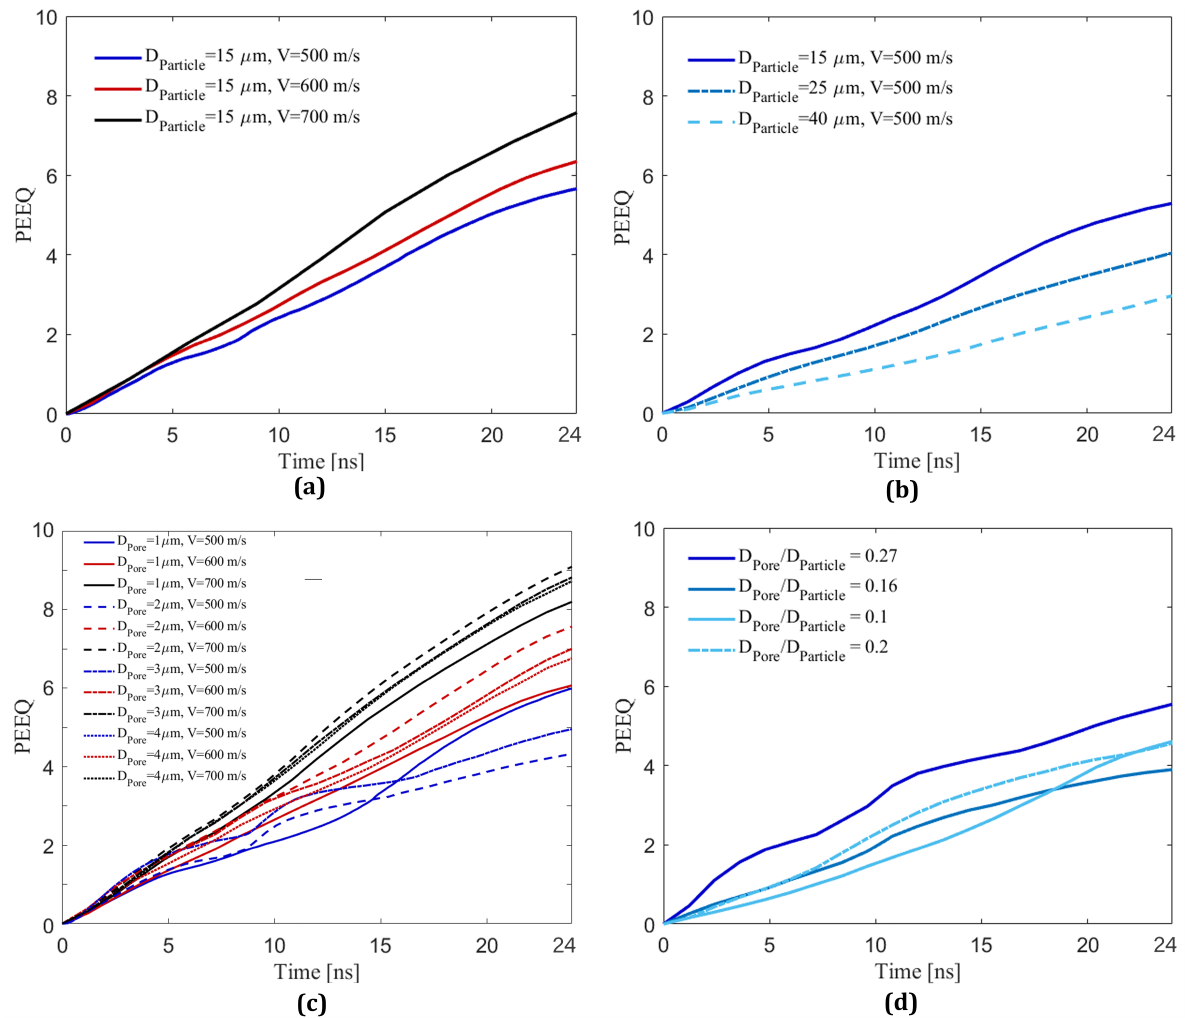
Figure 8. Time-evolved equivalent plastic strain (PEEQ) over the contact-surface between the Al substrate and the B 4 C particle in the Al substrate. ( a ) Particles with D Particle = 15 µ m and V Impact = 500, 600, and 700 m/s. ( b ) Particles with D Particle = 15, 25, 40 µ m and the V Impact = 500 m/s. ( c ) D Particle = 15 µ m and V Impact = 500, 600, and 700 m/s with a pore of D Pore = 1, 2, 3, and 4 µ m placed at a depth of 0.4 D Particle . ( d ) Particles with D Particle = 15, 25, and 40 µ m and V Impact = 500 m/s impacting on a substrate including a pore with diameters of D Pore = 4 and 8 µ m placed at a depth of 0.4 D Particle . The curves associated with D Pore of 0.27, 0.16, 0.1, and 0.2 correspond to D Pore D Particle 4 , 4 , and 8 , 25 40 40